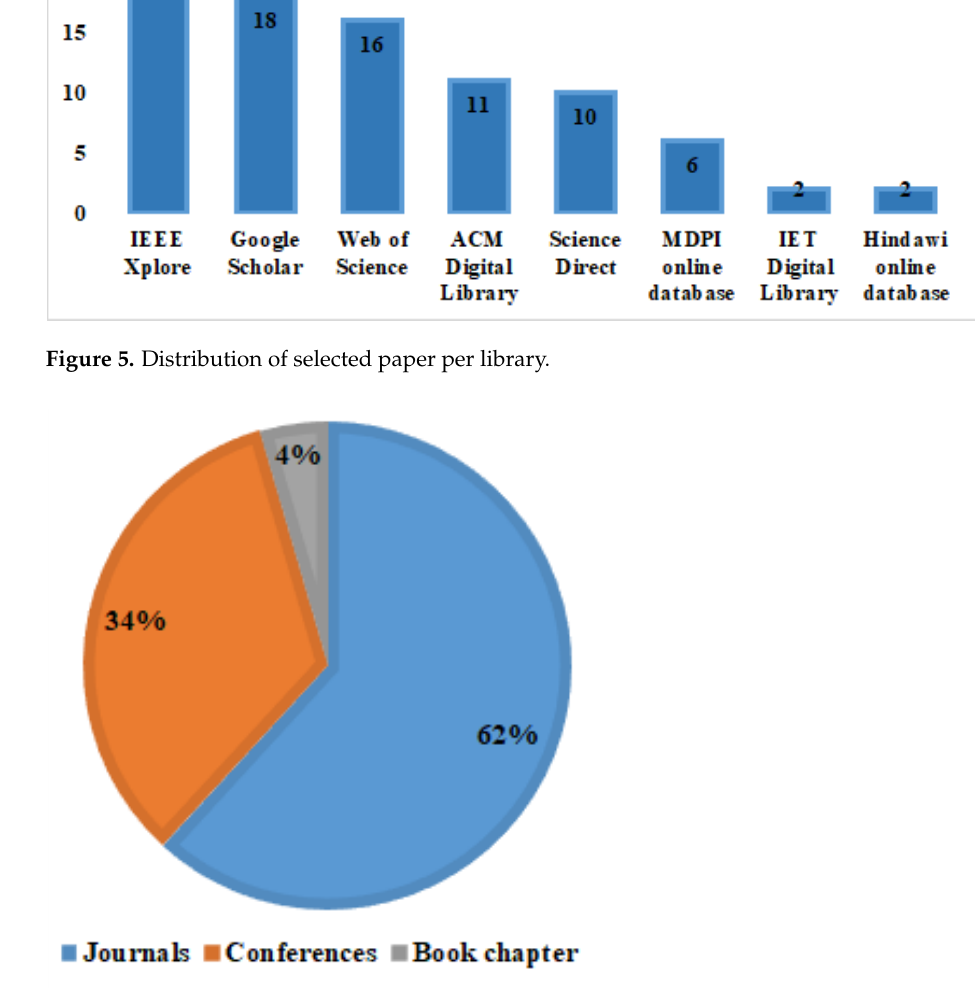
Figure 6. Distribution of selected paper per publication